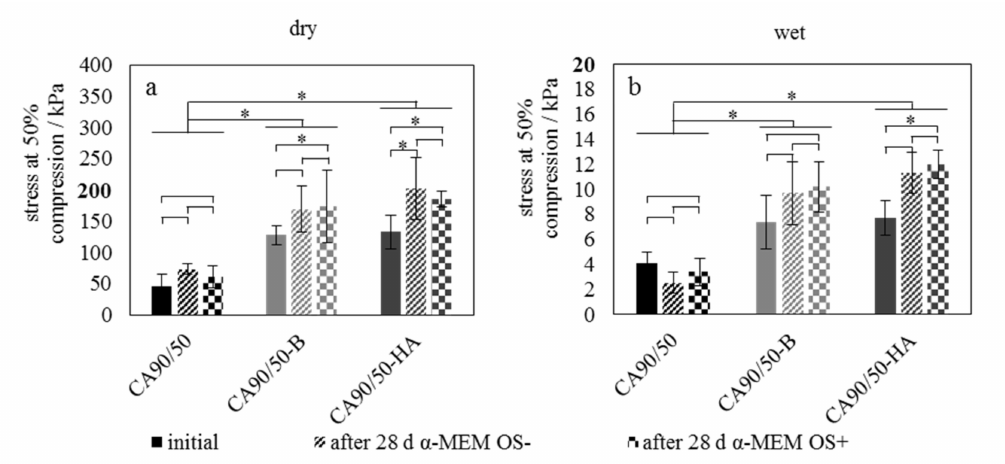
Figure 2. Stress at 50% uniaxial compression of pure and calcium-phosphate-modified chitosan sca ff olds in ( a ) dry state and ( b ) wet state, both in the initial state after preparation of the sca ff olds and after incubation in cell culture medium without and with osteogenic supplements over 28 days. An asterisk indicates significant di ff erence with a p value of <